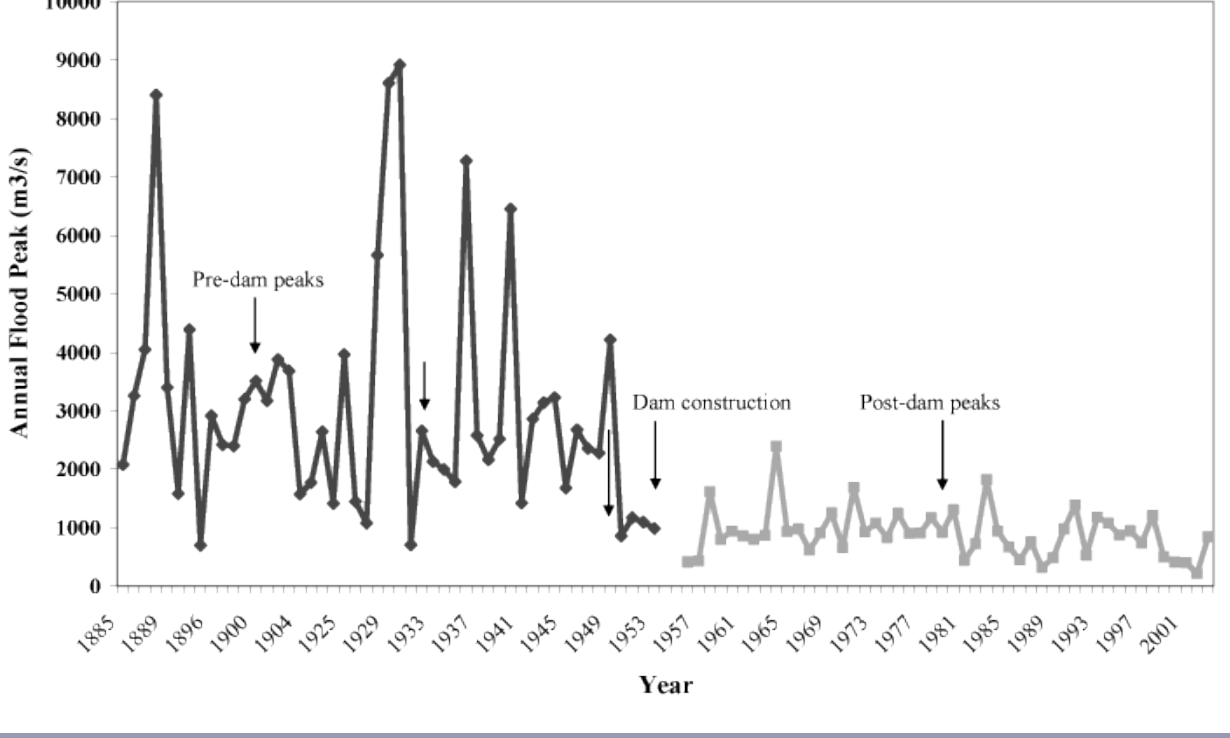
Fig. 5. Annual floods have been substantially lessened on the Savannah River since the construction of Thurmond Dam in